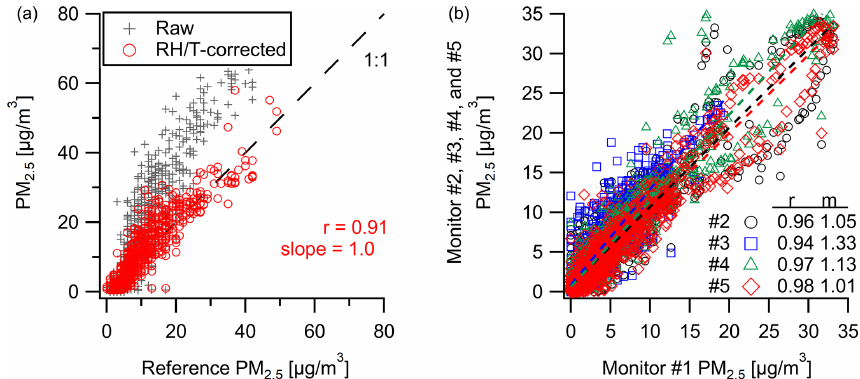
Figure 2. Comparison of PM 2 . 5 concentrations between (a) our monitor and the Baltimore Oldtown site reference measurements and (b) an intercomparison of five co-located PM sensors over 2.5 weeks in New Haven where there is a high degree of correlation with measurements even at 10min resolution (time series data can be found in Fig. S8).